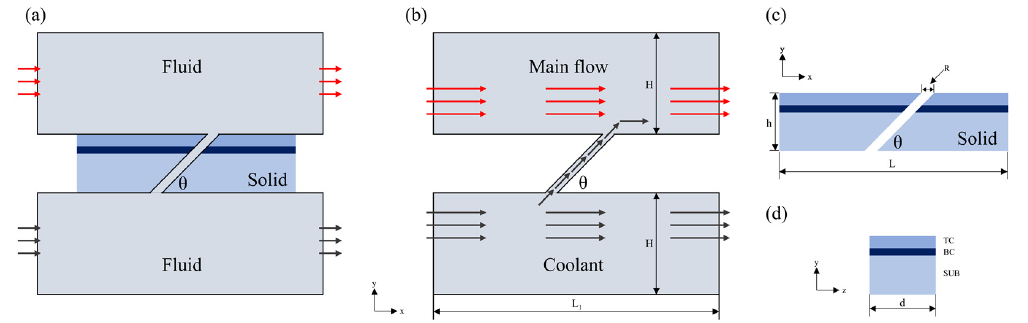
Figure 1. ( a ) Outlined photograph for TBCs with film cooling hole combined with fluid and solid domain, ( b ) fluid domain in xy plane, ( c ) solid domain in xy plane, and ( d ) yz plane.